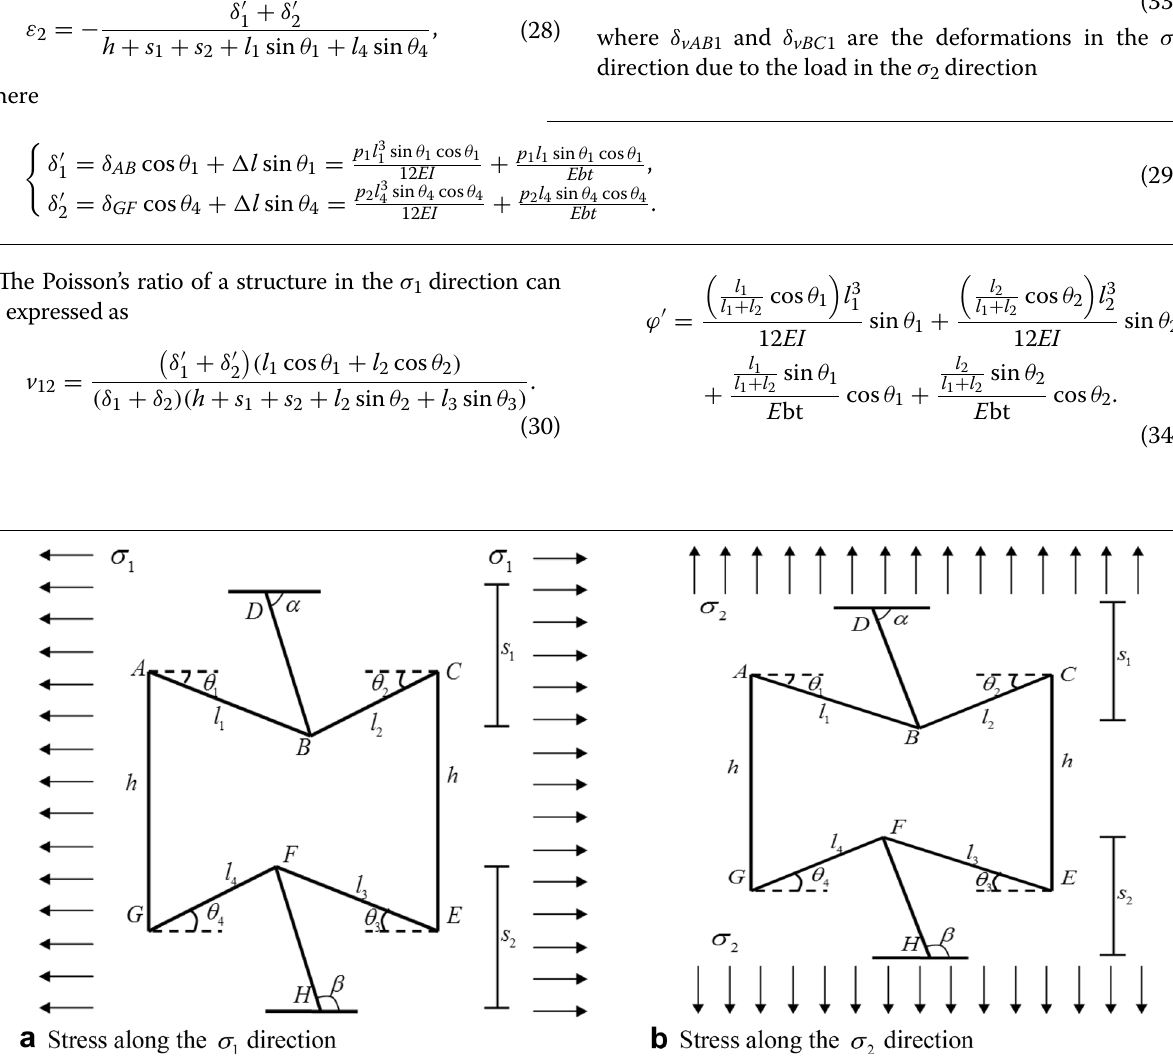
Figure 7 Tensile stresses along the ( a ) σ 1 and ( b ) σ 2